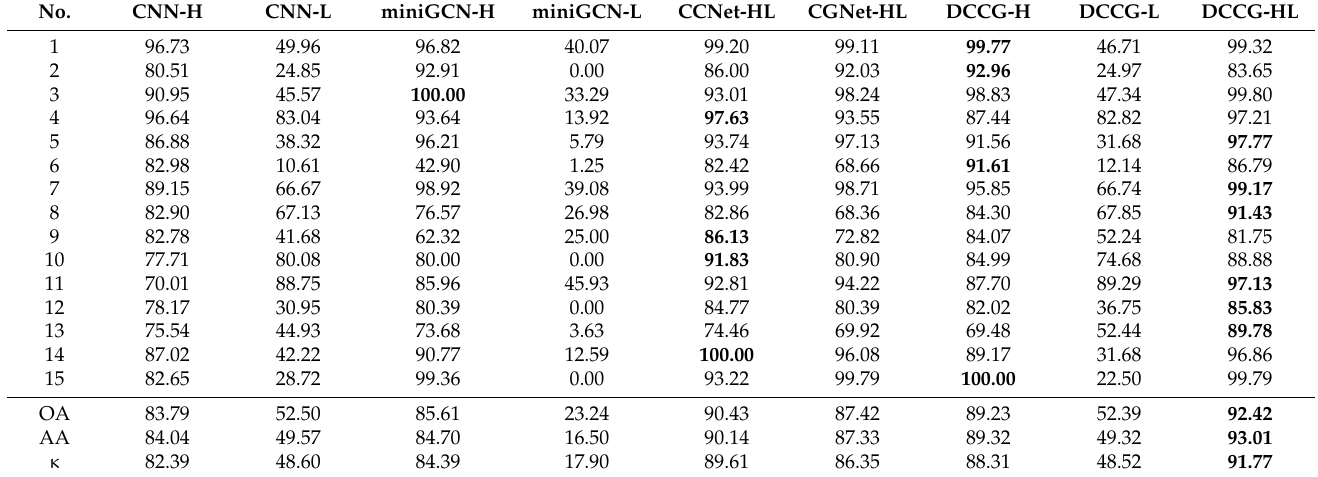
Table 4. Per-class accuracy, OA, AA and κ obtained by different methods on Houston data. The bold text in each row indicates the best classification